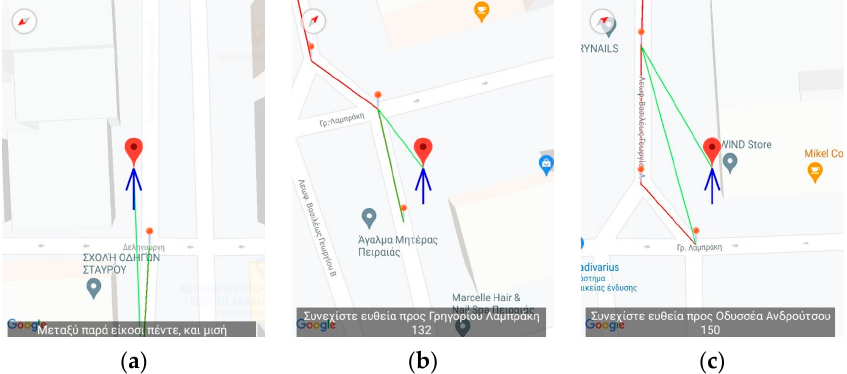
Figure 5. Application’s Training version—Midway through the virtual navigation. The figures display the navigation messages issued from the application. The translation of the text is as follows: ( a ) The user deviates from the correct navigational pat and the application issues the following error-correction message: “The correct direction is between 6 and 7 o’clock”, ( b ) “Continue straight ahead towards Grigoriou Lampraki 132”, ( c )“Continue straight ahead towards Androutsou 150”.